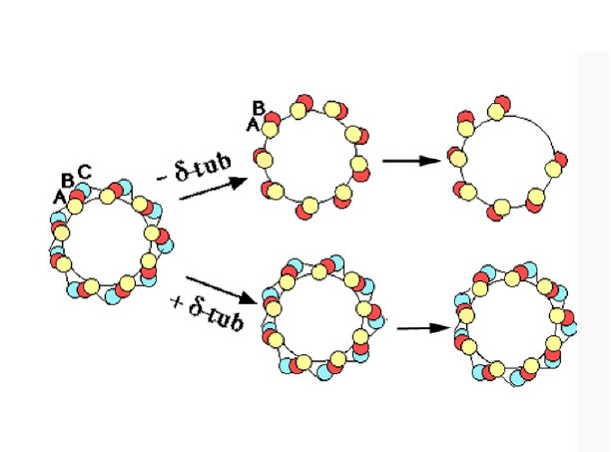
Figure 4 Schematic representation of the effect of δ PT1 inacti- vation on basal body organisation. In addition to micro- tubules, fibrous links of unknown molecular nature are represented: linkers between C-tubule of a triplet and the A- tubule of the adjacent triplet [15] (see Figure 3, d-d'), and the dense material lining the inside of the cylinder, visible on favorable sections above the cartwheel region. Note that the loss of the C-tubule suppresses the A-C linker between adja- cent triplets. Upon δ -tubulin depletion, duplication repro- duces the doublet condition, but can generate further microtubule loss, as illustrated in Figure 3 (b'), (c'), (e)